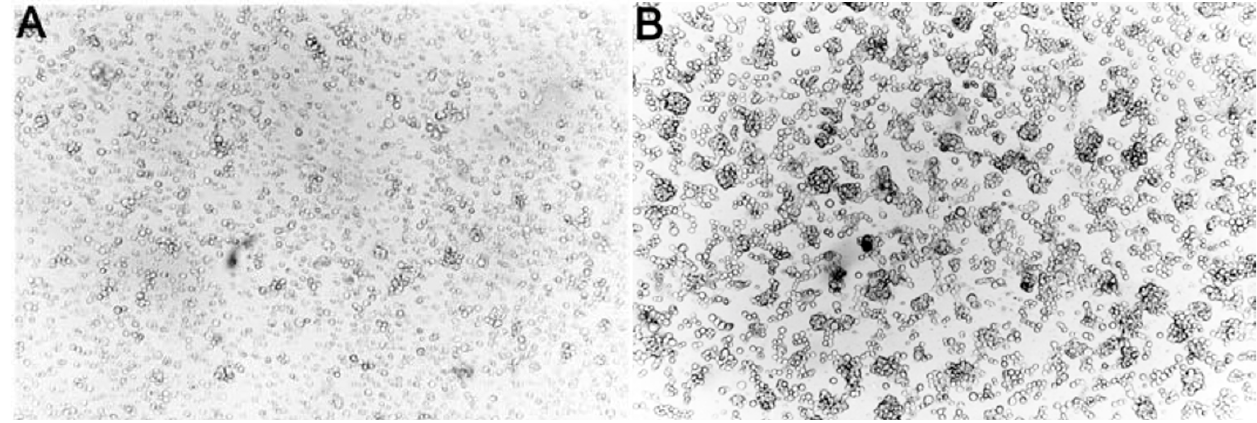
Figure 1 Light microscopy of S2 cells. In (A) the P0 transfected S2 cells are not induced to express protein and show only limited aggregation tendencies. In (B) the transfectants were induced with copperions and cell aggregates are clearly visible already 1-2 hours after induction. Pictures were taken at 10 x